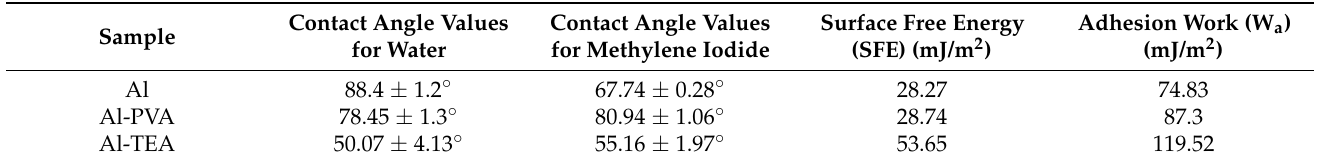
Table 2. Contact angle, surface free energy, and adhesion work values for the Al and modified Al plates.